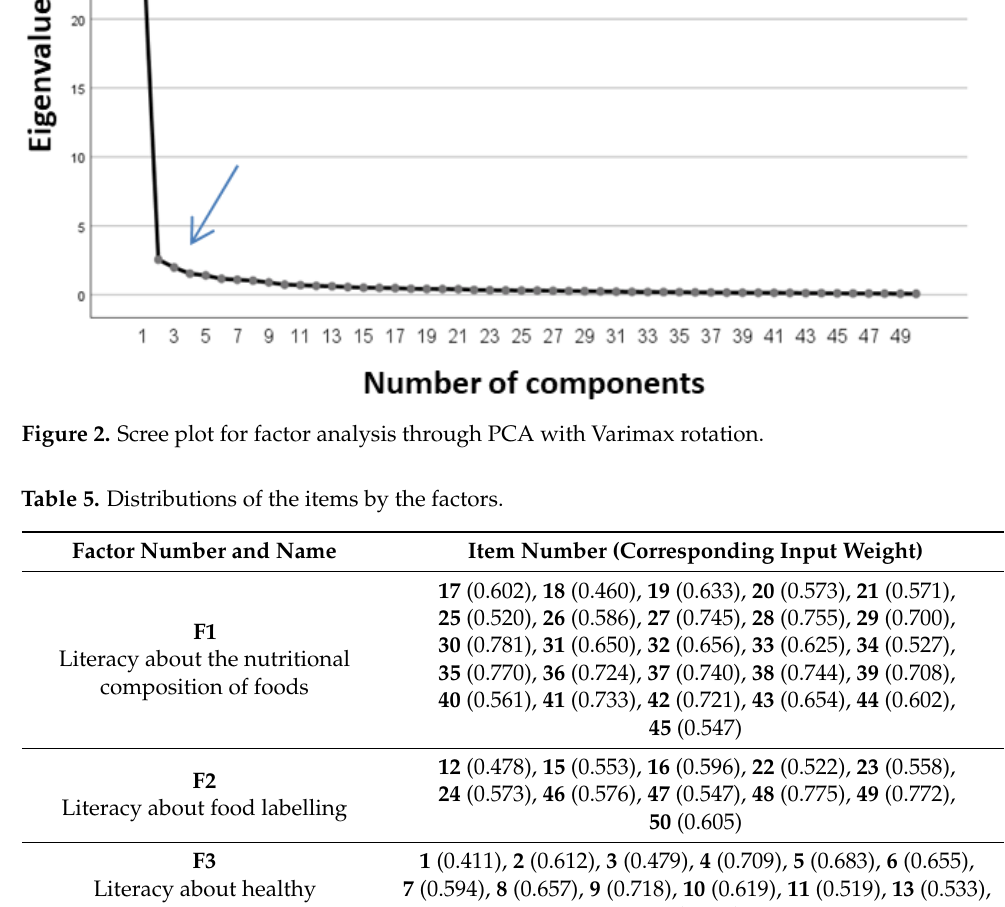
Table 5. Distributions of the items by the factors.